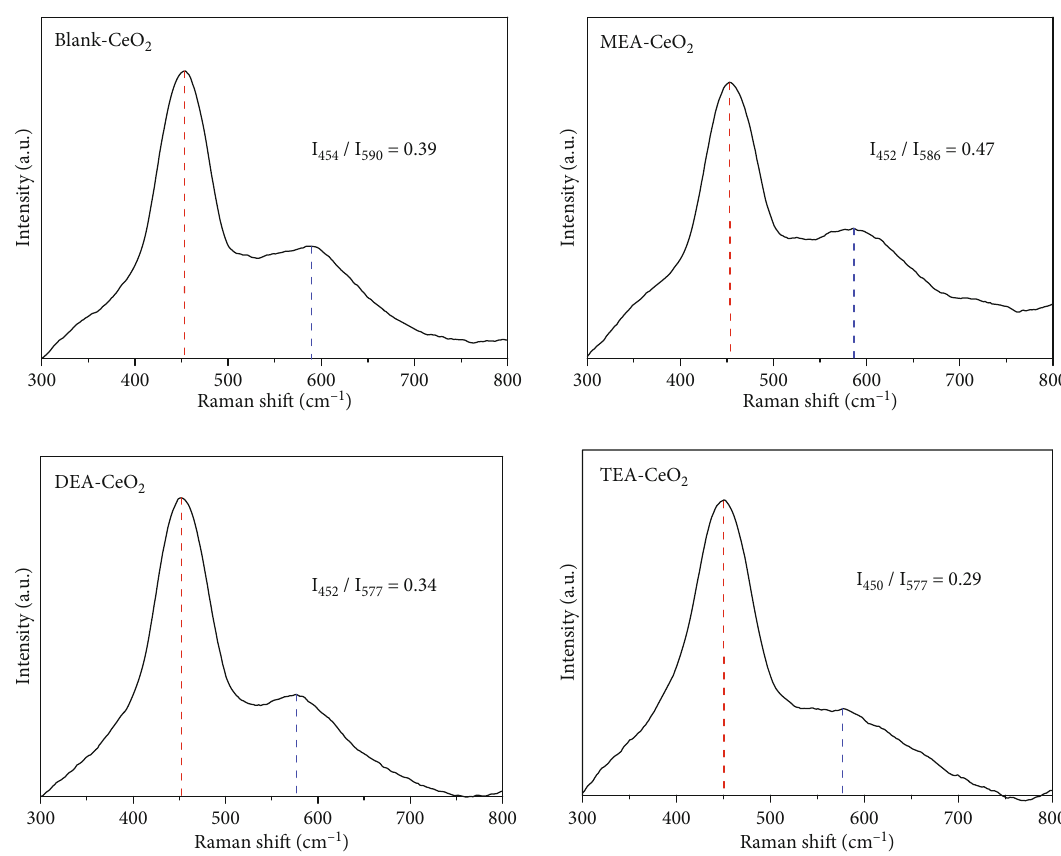
Figure 5: Raman spectra with 325nm laser excitation for Blank-, MEA-, DEA-, and TEA-CeO